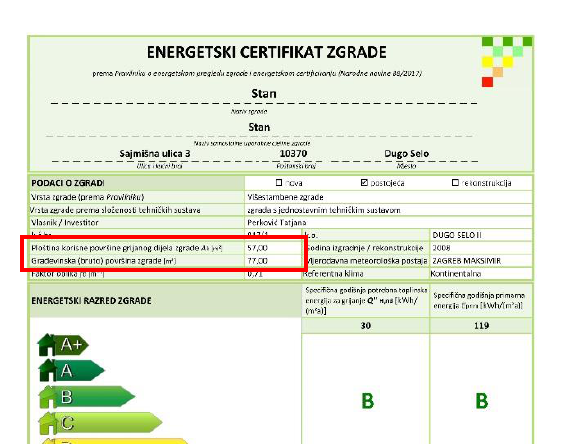
Figure 6. Building Energy Certificate